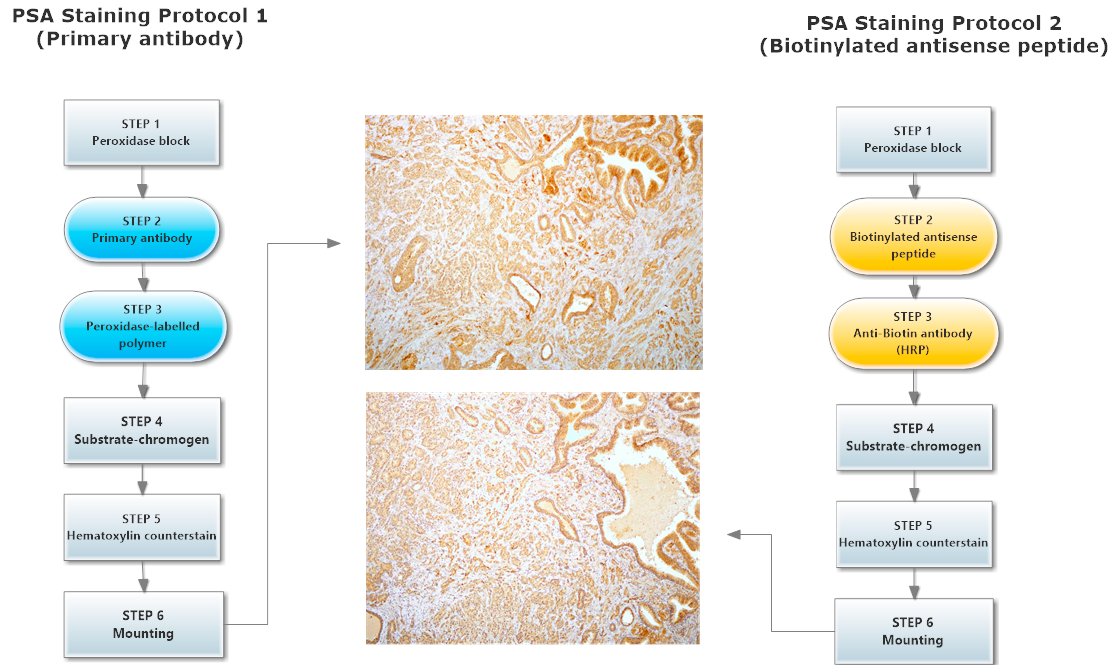
Figure 5. Two hPSA immunohistochemical staining protocols. The first is based on standard immunohistochemistry using a primary antibody (Protocol 1), while the second method is a novel procedure based on a biotinylated antisense peptide (Protocol 2).